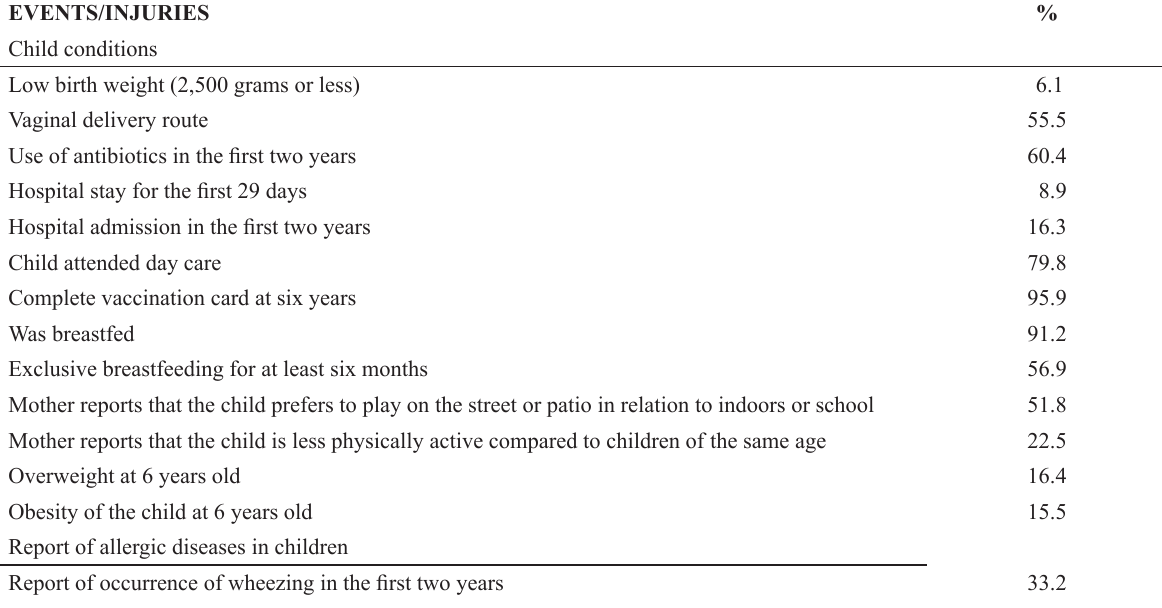
Preliminary results of events and injuries selected from the Coorte Brasil Sul study, Palhoça / SC. (n=1,270).